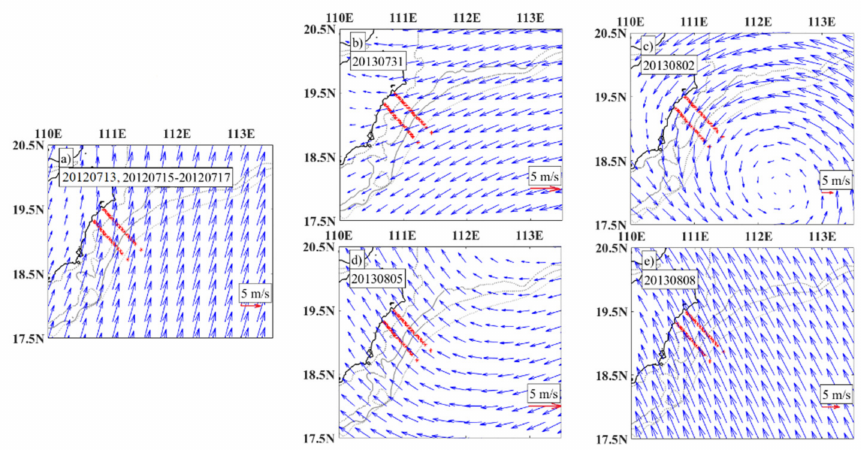
Figure 2. Sea surface wind vectors (blue arrows) in the case without the typhoon on 13 and 15–17 July 2012 ( a ), before the typhoon on 31 July 2013 ( b ), during the typhoon on 2 August 2013 ( c ), and after the typhoon on 5 ( d ) and 8 August 2013 ( e ). Red starts represent observation stations in the two sections H and F. Gray lines represent isobaths of 50, 100, 150, and 200